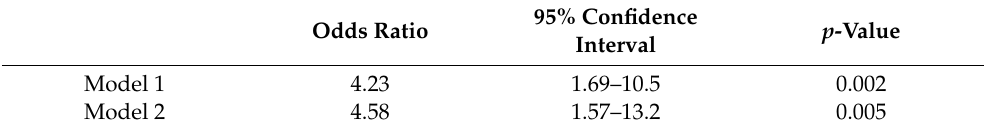
Table 3. Odd ratios of low preoperative hand grip strength for postoperative